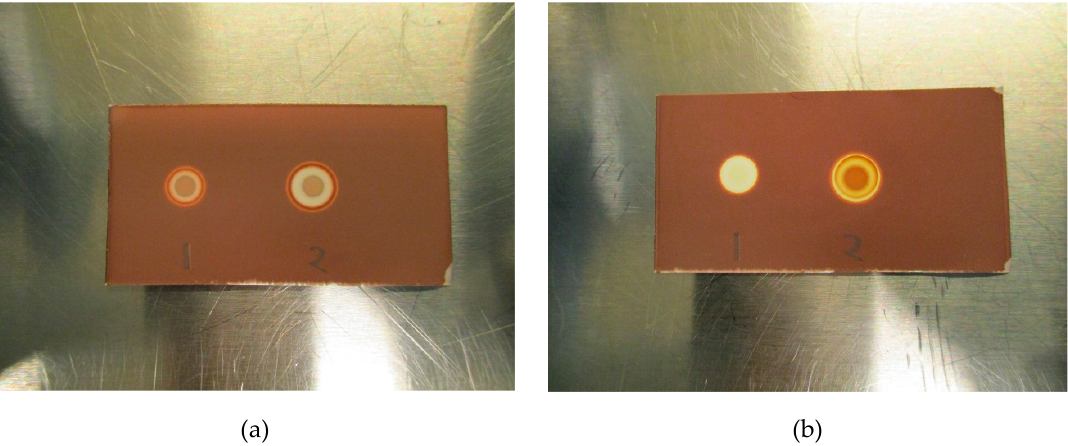
Figure 1. (a ) Initial test without antioxidant: (1) Tetrabutylammonium (TBA) standard (0.26 mg/mL), (2) TBA standard (0.26 mg/mL) + water. ( b ) Initial test with antioxidant: (1) TBA standard (0.26 mg / mL), (2) TBA standard (0.26 mg / mL) + H 2 O 2 .